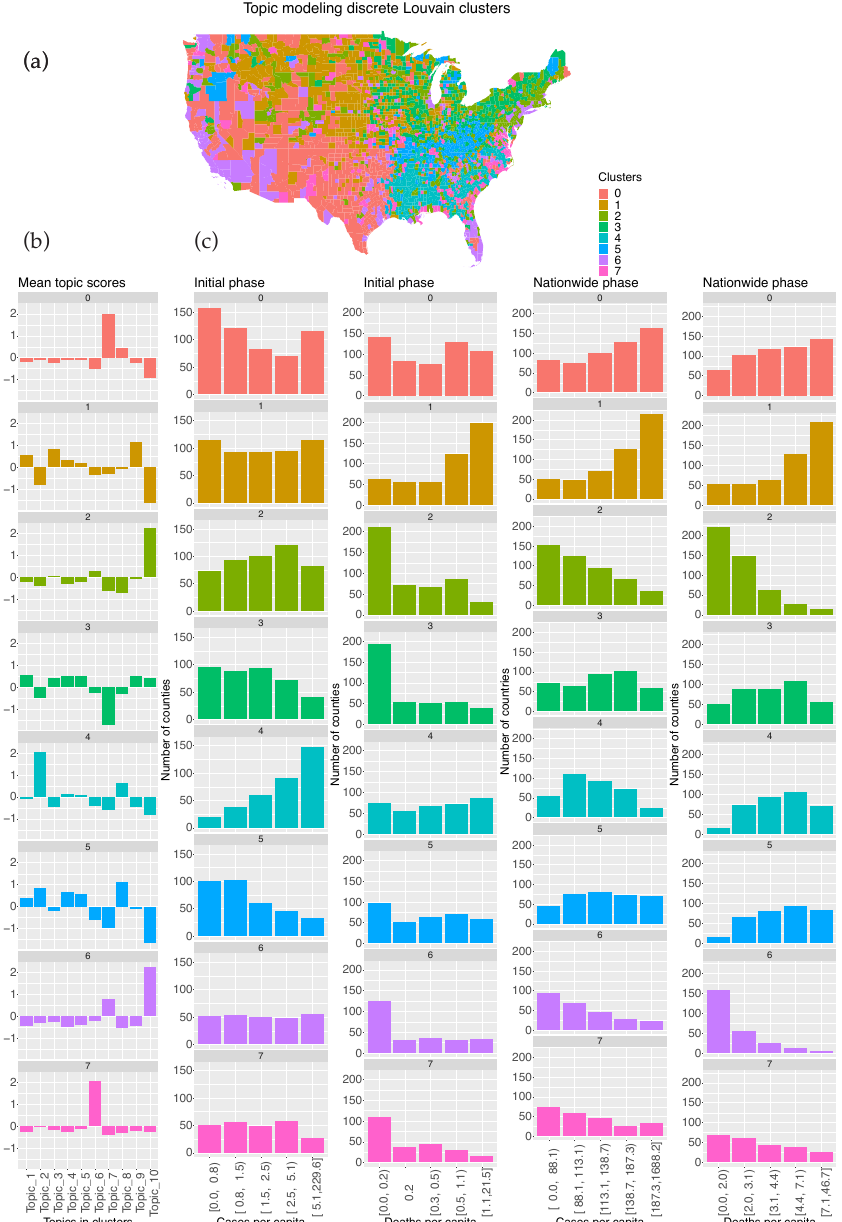
Figure 5. Counties clustered using spatial topics show similar patterns in COVID-19 cases/death counts. Clustering by topics can identify high- and low-risk counties. ( a ) Geographical map of counties and their discrete cluster assignments when topic-county matrix inputted into Louvain clustering. ( b ) Mean topic score for each topic for each of the 9 clusters of counties. ( c ) Bar graph of the number of countries within each cluster that fall within each quintile bin of cases and deaths for the initial as well as nationwide phases of the